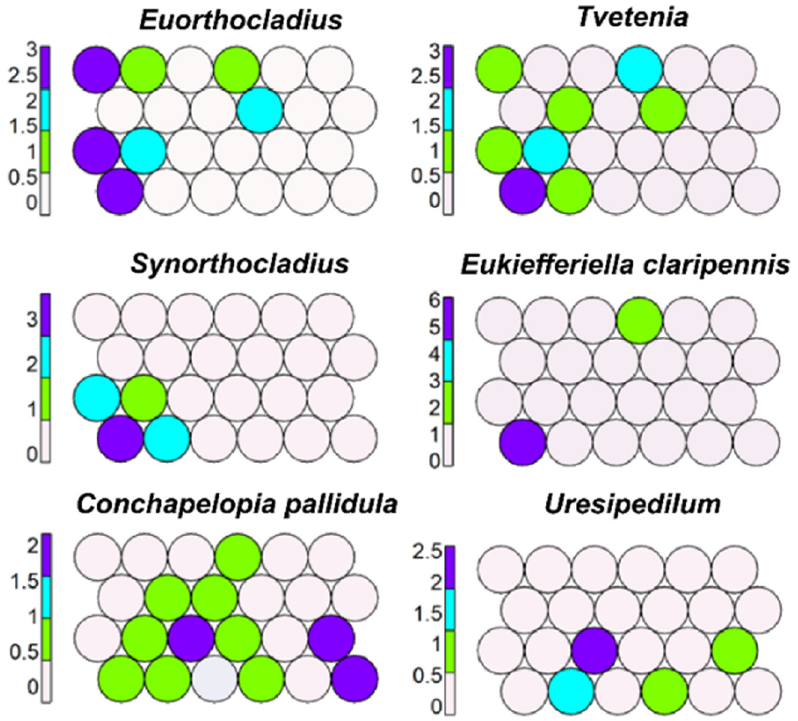
Figure 4. Unsupervised map of six morphotaxa characterizing rhithral (upper sector). Sympotthastia , Orthocladius rubicundus , Cricotopus tremulus , C. bicinctus (Figure 5) were mapped in cells representing lower rhithral zone; Potthastia , Rheotanytarsus , Eukiefferiella ilkleiensis, and Rheopelopia (Figure 5) were mapped in cells degrading from rhithral to po- tamal.